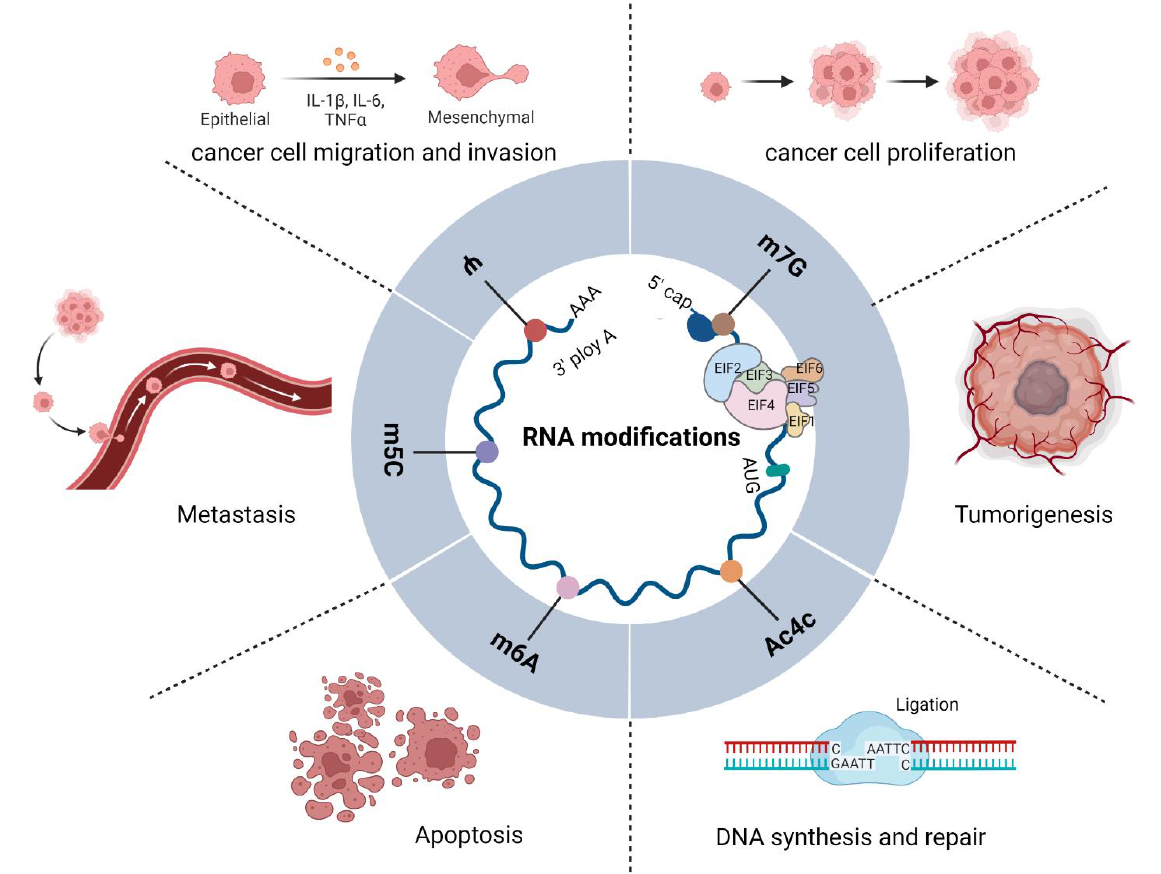
Figure 1. Functions of eIFs and RNA modifications in tumors. Diagram showing the functions of eIFs and m 6 A, m 6 Am, m 5 C, Ψ, and ac 4 C in RNA modification. A variety of eIFs constitute